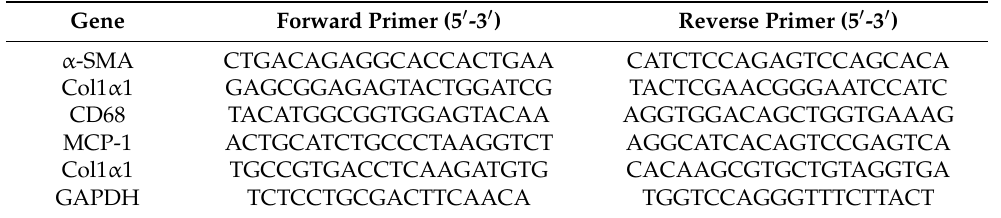
Table 1. Primer sequence for